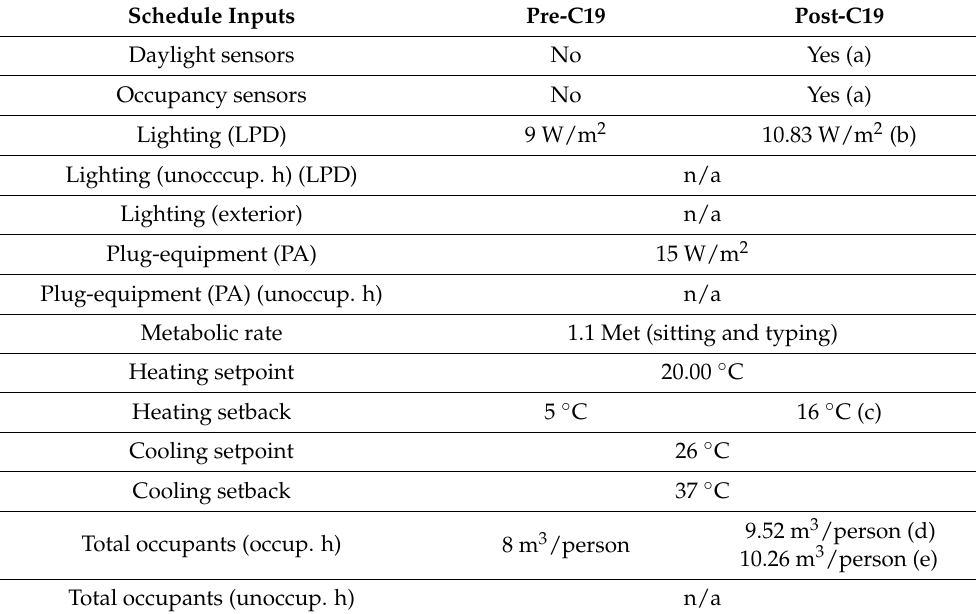
Table 8. Summary of Cove.tool schedules inputs in pre- and post-C19 scenarios.